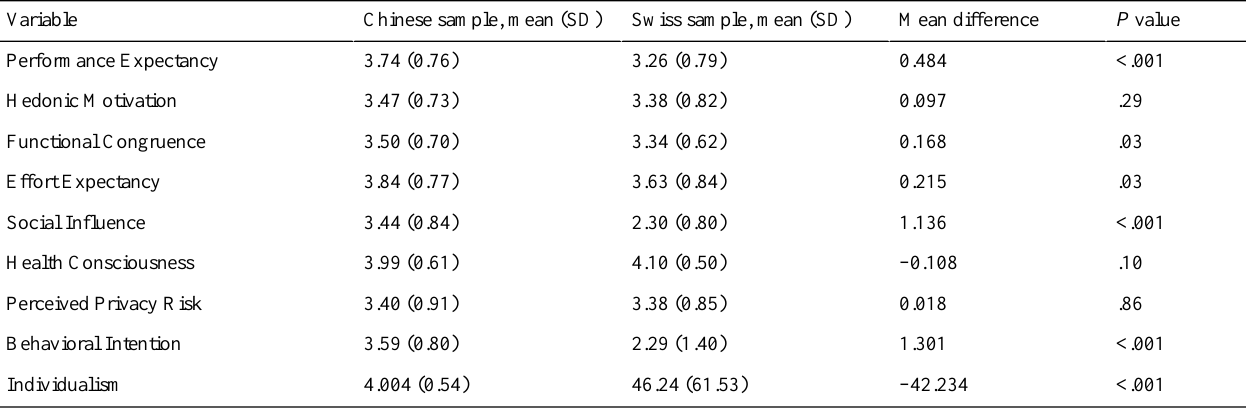
Table 6. Comparing perceptions of the Chinese and Swiss (t